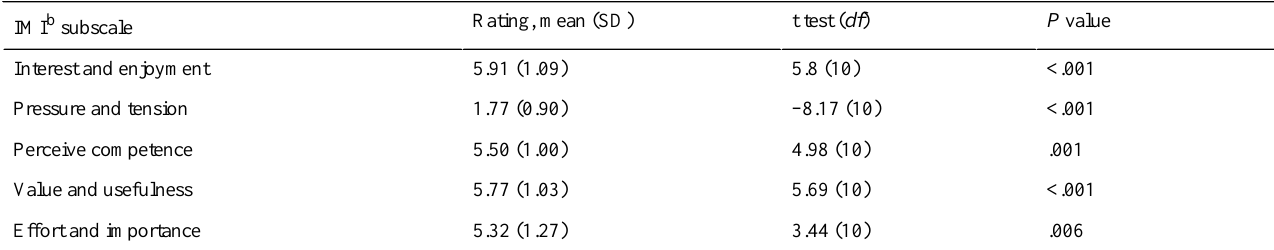
Table 2. IMI of the Stomp Joy intervention among patients with stroke.